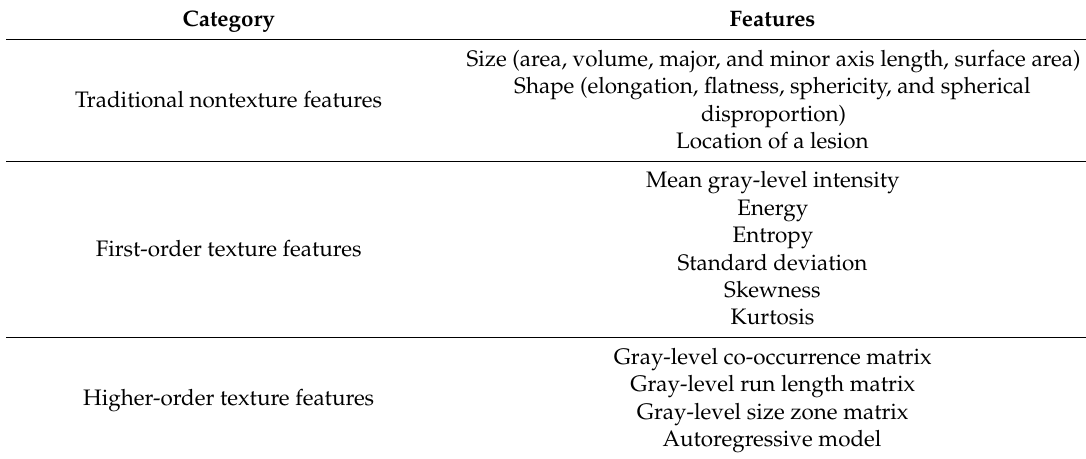
Table 1. Summary of most frequently used radiomic